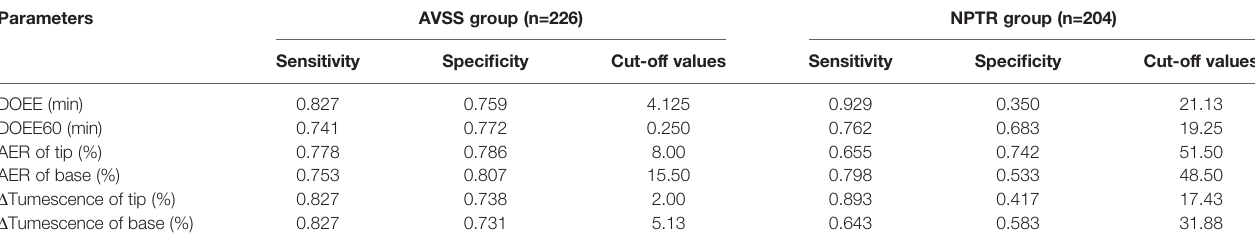
TABLE 5 | Optimal cut-off values between AVSS group and NPTR group in cured patients predictions.